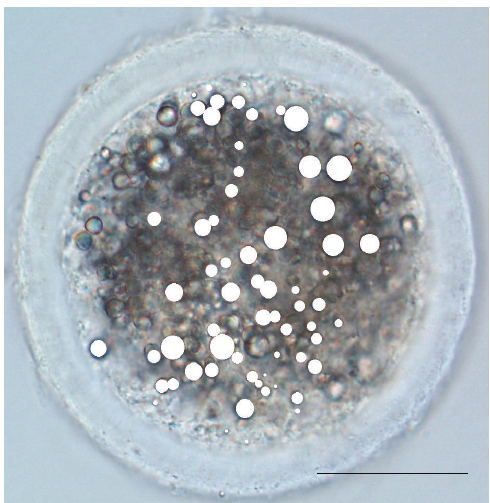
Figure 3: Immature pig oocyte with lipid droplets (LD) highlighted in white colour (LD areas were measured using Image J software) and scale bar 50 𝜇